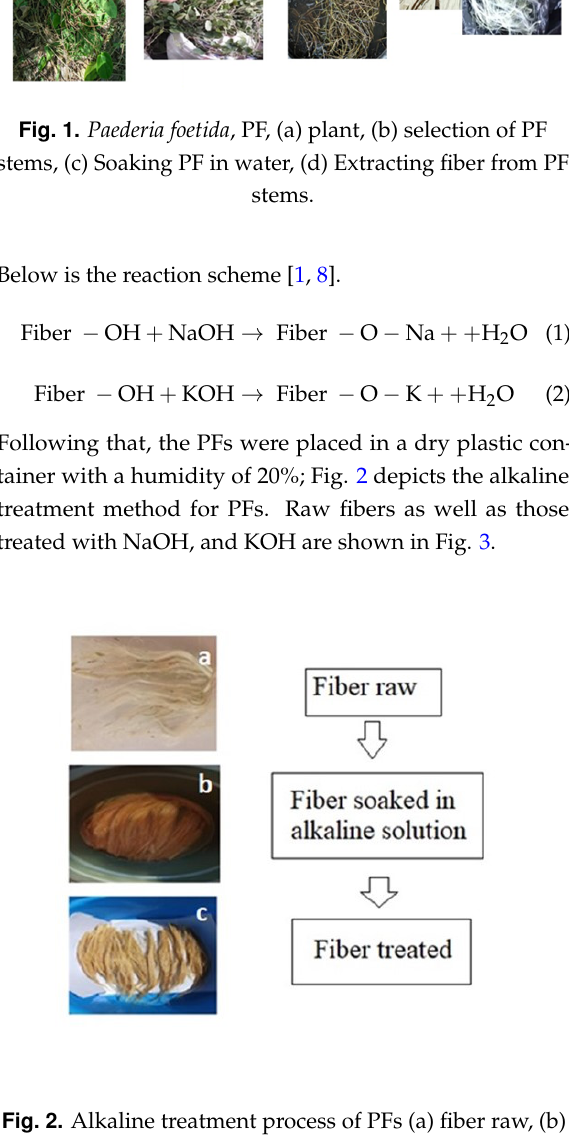
Fig. 2. Alkaline treatment process of PFs (a) fiber raw, (b) alkalization, and (c) dry PFs.